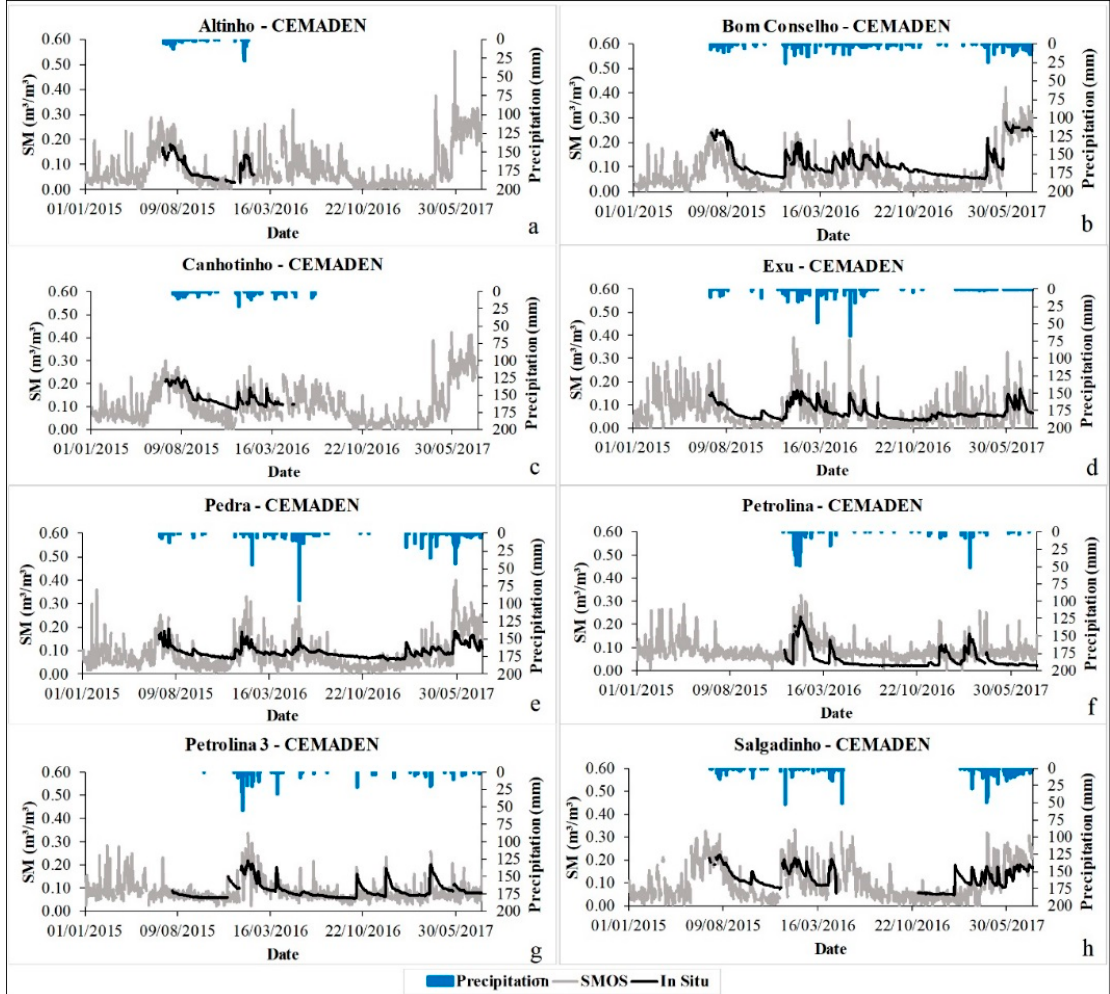
Figure 5. Daily soil moisture from CEMADEN stations, SMOS data, and measured precipitation during the period of July 2015 to July 2017. Each graph refers to a station.